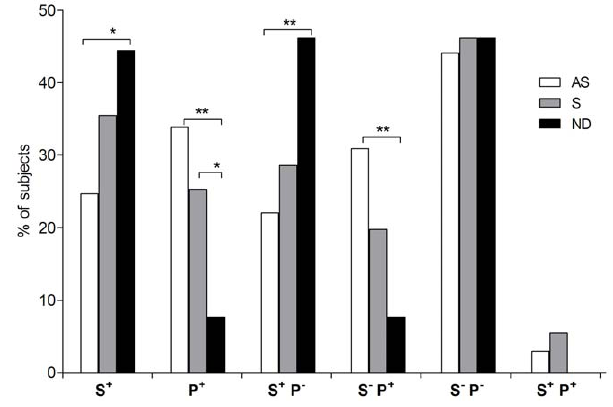
Figure 1. Combinations of ‘‘susceptible’’ (S) and ‘‘protective’’ (P) alleles. The histogram displays the percentage of subjects with the phenotype indicated below the X axis in the three WNV + groups: asymptomatic (AS), symptomatic (S), and having a neuroinvasive disease (ND). ** P , 0.01 and * P , 0.05. doi:10.1371/journal.pone.0022948.g001 PLoS ONE |